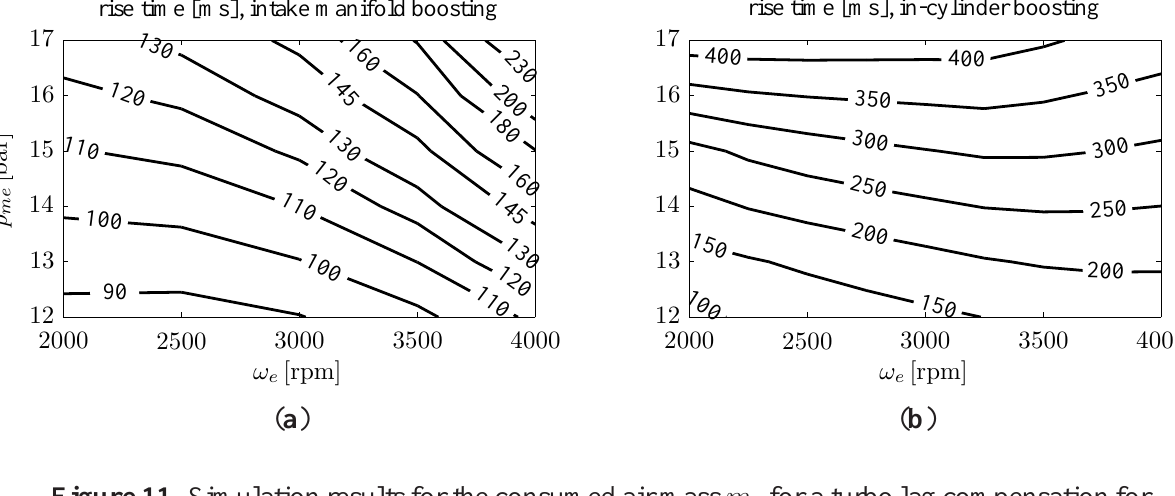
for a turbo lag compensation for b to the indicated p at the indicated engine speed ω . ( a ) With me me e